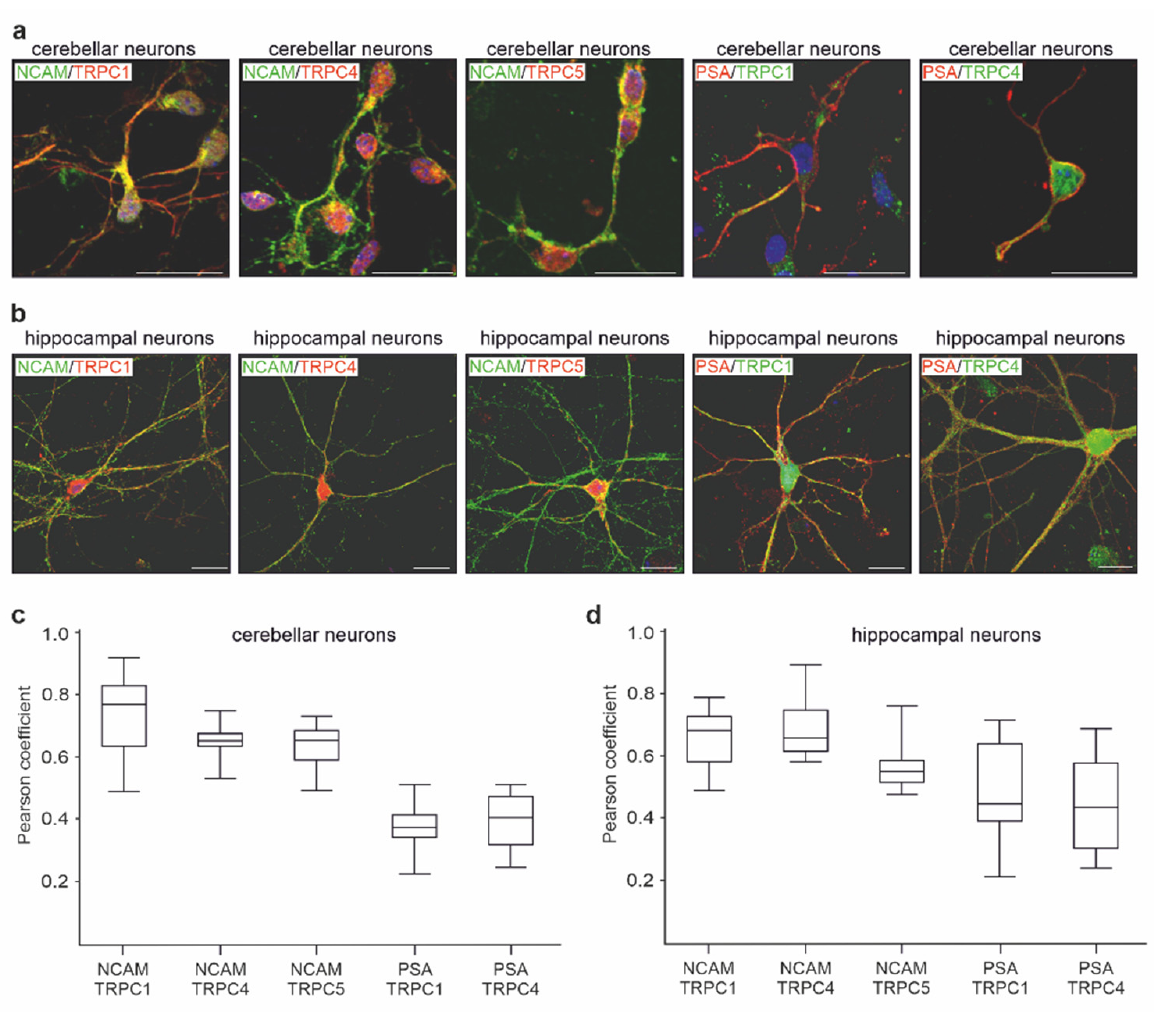
Figure 4. NCAM colocalizes with TRPC1, − 4, and − 5 in hippocampal and cerebellar neurons. Cultured neurons were subjected to double immunostaining with rabbit NCAM antibody GTX133217 and mouse TRPC1 antibody E-6, TRPC4 antibody N77/15, or TRPC5 antibody N67/15, as well as with mouse PSA antibody 735 and rabbit TRPC1 antibody GTX54876 or rabbit TRPC4 antibody ACC-119. Nuclei were stained with DAPI (blue). ( a , b ) Representative images are shown for co- immunostaining of TRPC1 (red) and NCAM (green) or of TRPC1 (green) and PSA (red) in cere- bellar ( a ) and hippocampal ( b ) neurons. Superimposition of red and green stainings shows colo- calization in yellow. Scale bar: 20 µm. ( c , d ) Pearson’s coefficients were determined from 10 im- munostained neurons per group and from 2 different cultures. Box plots show the Pearson’s coef- ficients and indicate an overlap of NCAM or PSA stainings with TRPC stainings in cerebellar ( c ) and hippocampal ( d ) neurons.